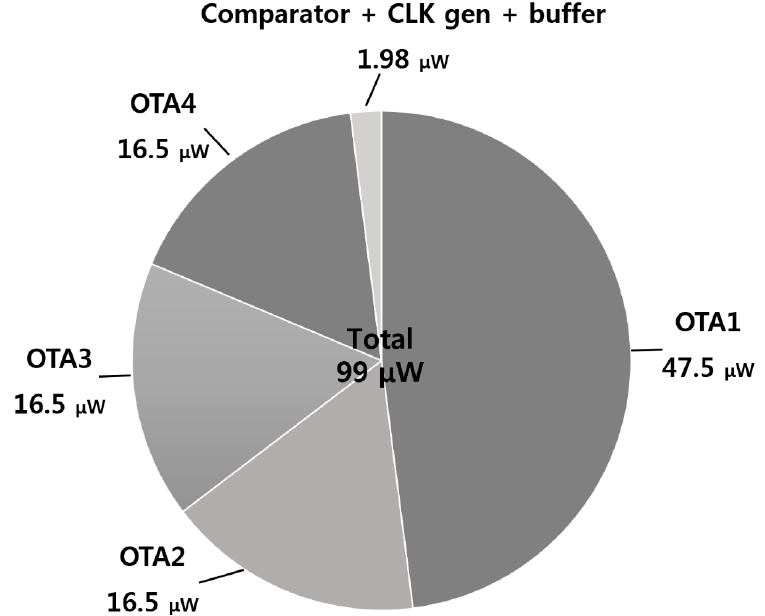
Figure 14. Power breakdown.